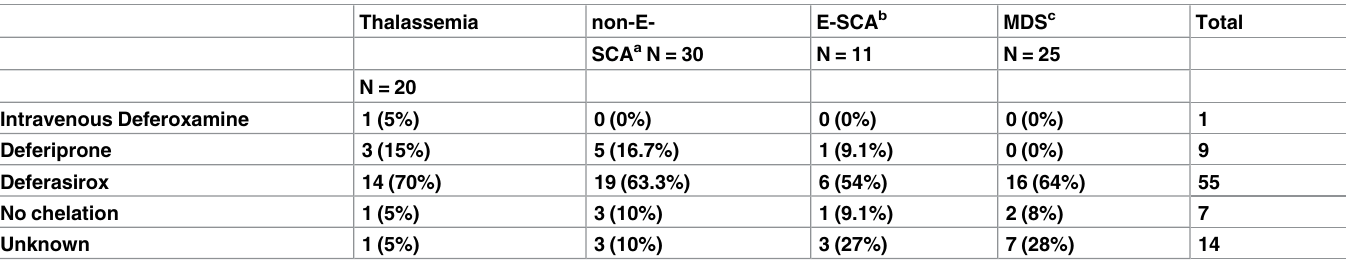
Table 3. Chelators